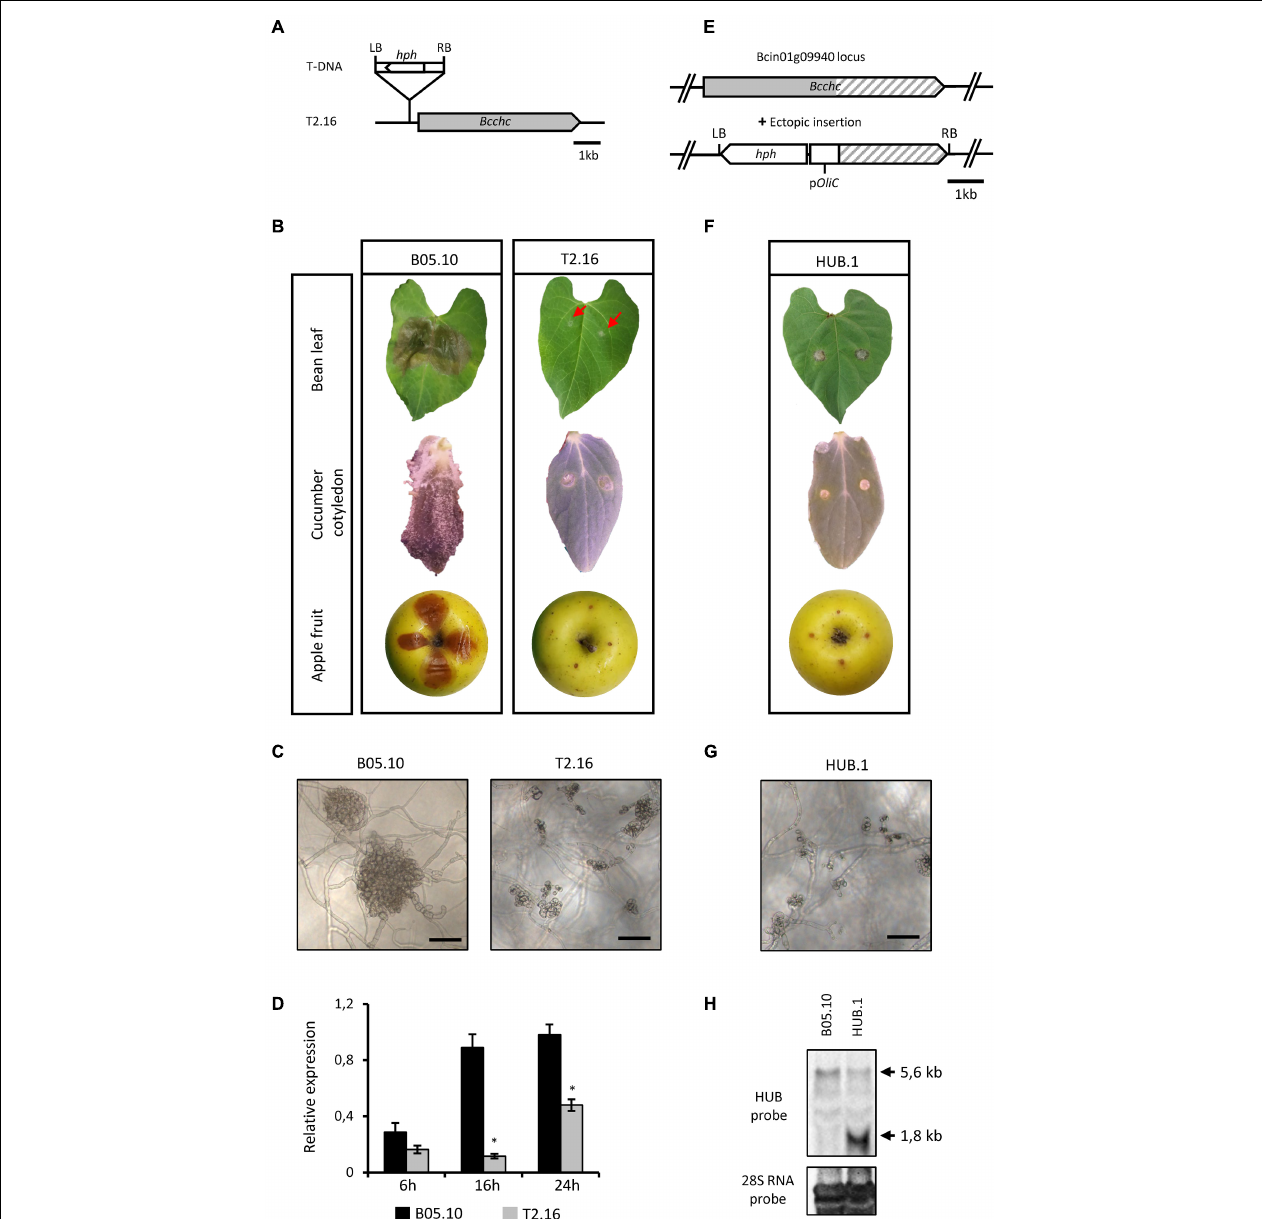
FIGURE 1 | Characterization of the T2.16 and HUB mutants of B. cinerea . (A) Schematic representation of the mutated locus in the T2.16 strain generated by A. tumefaciens -mediated transformation. Insertion of the bacterium T-DNA ( hph hygromycin B resistance gene flanked by the bacterial left (LB) and right (RB) border regions) occurred 297 bp upstream of open reading frame of the clathrin heavy chain-encoding gene Bcchc and was localized by rescue-PCR analysis. (B,F) The virulence of the T2.16 and HUB mutants was compared to that of the parental strain B05.10 on primary leaves of French bean, cucumber cotyledons and wounded apple fruits. Pictures were taken 4 days post-inoculation. (C,G) Infection cushions were observed by inverted microscopy after 72 h of incubation in liquid PDB 1/4 medium on plastic surfaces (scale bar 50 µ m). Photos and data are representative of three independent experiments. (D) Bcchc expression in the parental (B05.10) and the T2.16 mutant strains during a kinetic of fungal growth on Teflon membranes. Mycelia were harvested at 6 h, 16 h and 24 h after inoculation. Bcchc expression is plotted relatively to that of the Bcpda1 housekeeping gene [the same results were obtained with two other reference genes (see Methods)]. Three independent biological replicates were assessed for each experiment. Standard deviations are indicated. Asterisks indicate a significant difference (Student’s t -test, ∗ p -value < 0.05). (E) Schematic representation of the DNA construct used to produce the-C-terminal domain of CHC (HUB fragment) in B. cinerea . The A. tumefaciens -compatible plasmid pBHT2 was used to place the HUB DNA sequence (dashed) under the control of the A. nidulans constitutive promoter pOliC. The hygromycin B resistance gene ( hph ) is shown as well as the left (LB) and right (RB) borders of the T-DNA. (H) Northern blot analysis. RNA extracted from the parental (B05.10) and HUB.1 strains were separated by gel electrophoresis and hybridized with labeled RNA probes corresponding to the HUB DNA sequence (top) or to the 28S RNA (loading control, bottom). Arrows indicate the hybridizing bands corresponding to the HUB fragment RNA (1.8 kb) and to the chc RNA (5.6 kb).